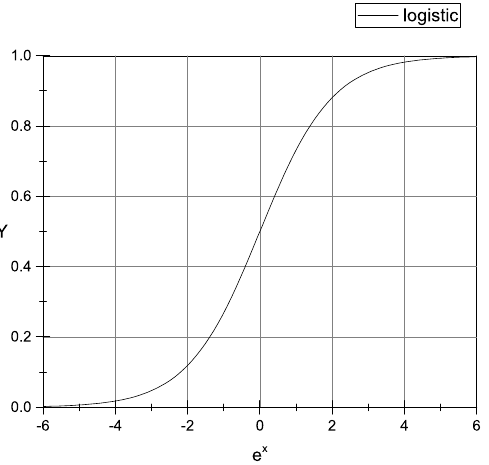
Figure 1. Logistic function curve: This is a standard logistic function, and it has a typical “S” shape (sigmoid